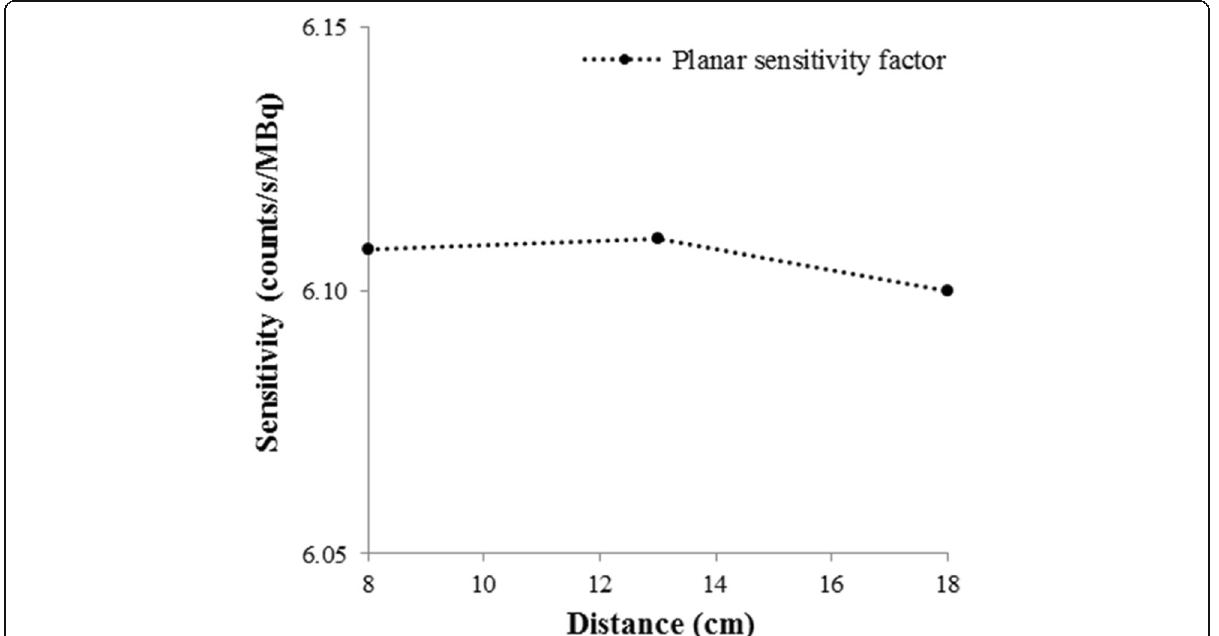
Fig. 1 Planar sensitivity variation in function of the distance from the detectors of the gamma camera GE-Discovery NM/CT 670. For each distance (8 cm, 13 cm, 18 cm), the planar sensitivity was estimated from the geometric mean using the Xeleris® software. A circular region of interest that delineates the source distribution was used. The planar sensitivity factor remained constant (6.11±0.01 counts/s/MBq) from 8 to 18